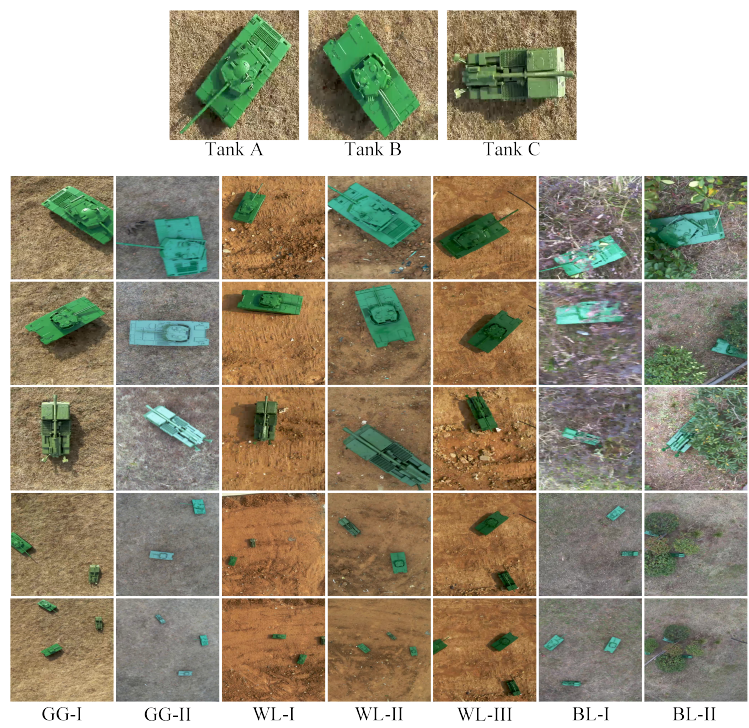
Figure 1. Visualization of the UAVT-3